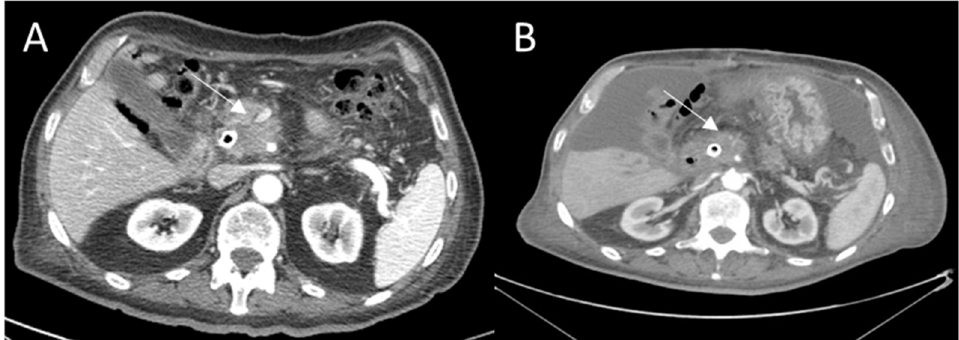
Figure 1. CHOI assessment before ( A ) and after ECT treatment ( B ) of an adenocarcinoma of the pancreatic head. After the treatment in pancreatic phase on CT study, the lesion appears hypodense ( B , arrow). There was a reduction in lesion density: 36% of reduction in the CT signal before and after treatment (partial response). Table 1. Comparison of WHO, RECIST 1.1, Choi, mRECIST, PERCIST Criteria. Response